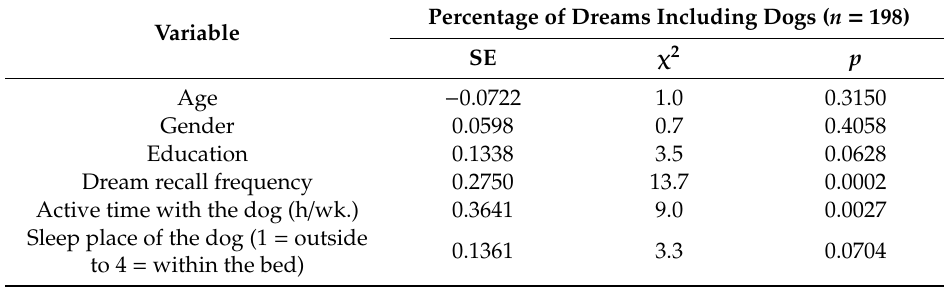
Table 5. Ordinal regression analysis for the categorized (ordinal) percentage of dreams that include dogs (for dog owners